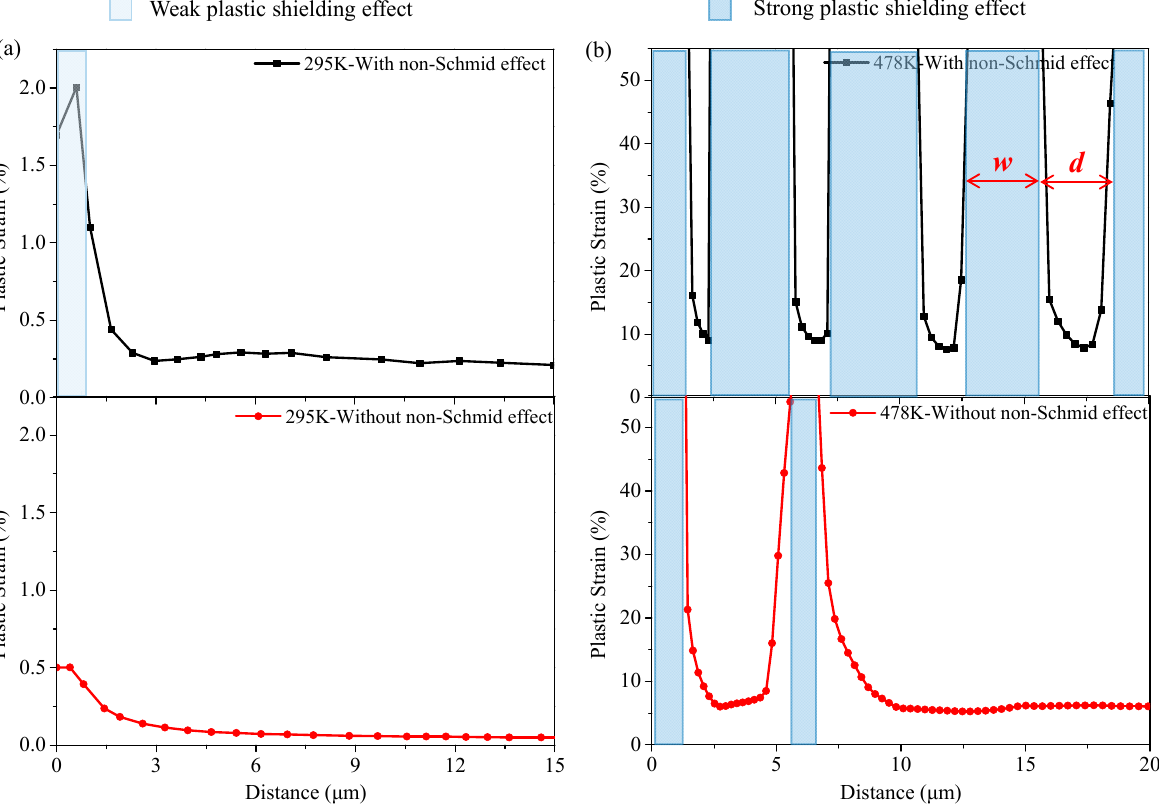
Figure 7. Influence of the NS effect on the plastic strain distribution along the crack plane for tungsten at two different temperatures of 295 K ( a ) and 478 K ( b ).